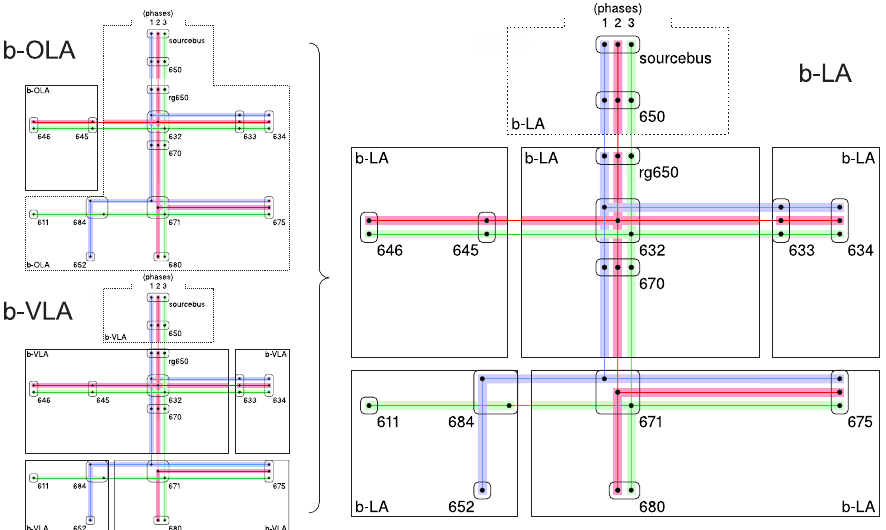
Figure 7. Example of